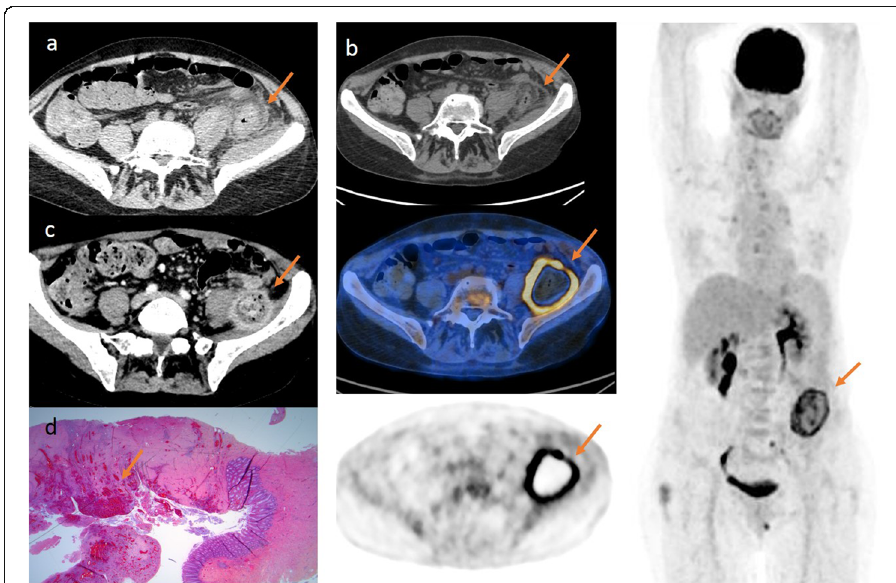
Fig. 1 Intestinal mucormycosis “ fungus ball ” located with [ 18 F]-FDG-PET/CT. a CT image on 3 November 2018 without contrast injection of aspecific colitis as shown by the orange arrow. b PET/CT image on 15 November 2018 of the intestinal fungus ball: left column: top panel: CT axial view without contrast; middle panel: fused PET/CT image; bottom panel: PET axial view; the right column shows a whole body volume – rendered image. The orange arrows show the intestinal fungus ball. c CT with the injection of contrast on 19 December 2018 showing a fibrotic inflammatory mass with necrotic center adhering to the iliopsoas muscle and encompassing the descending colon as shown with an orange arrow. d 03 January 2019: histological exam of intestinal resection. Coloration used: hematoxylin-eosin; magnitude: